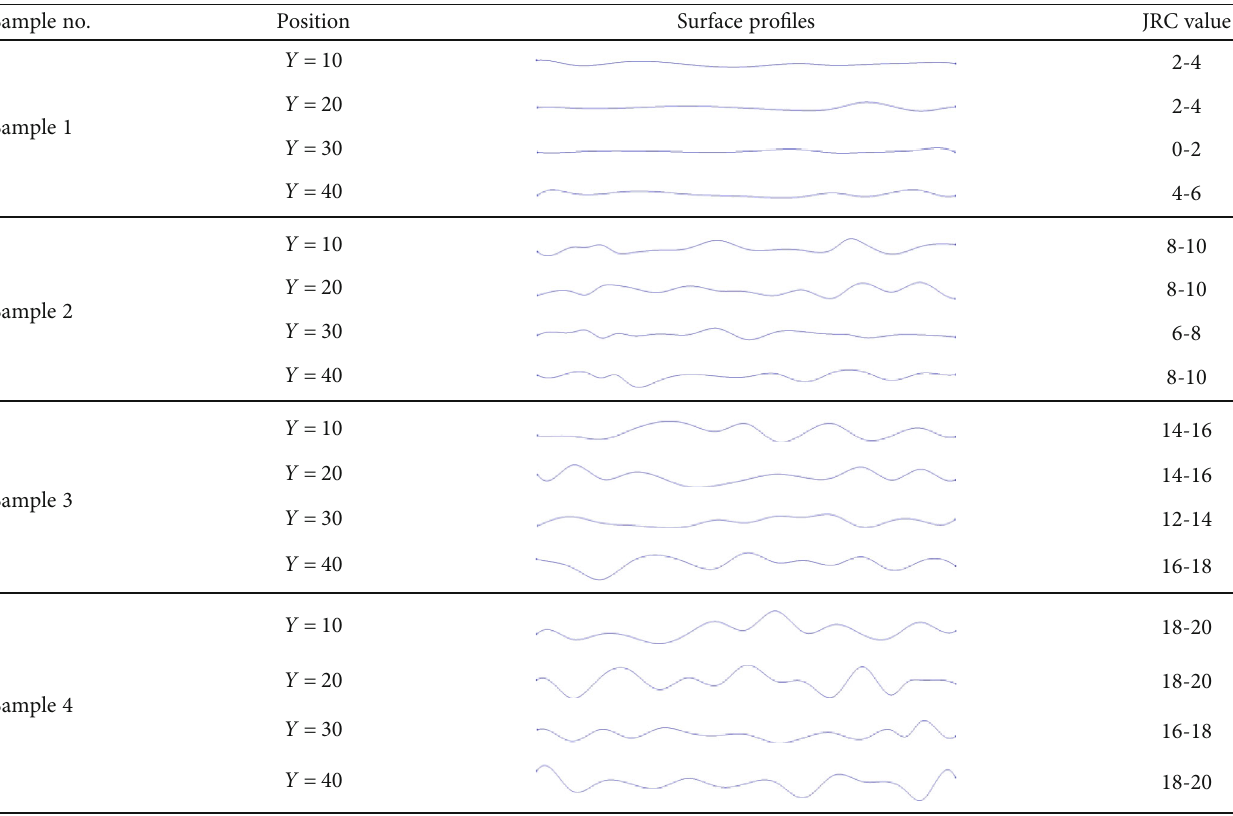
Figure 8: Morphology characterization of the fracture domains. Table 1: JRC value of the partial surface pro fi